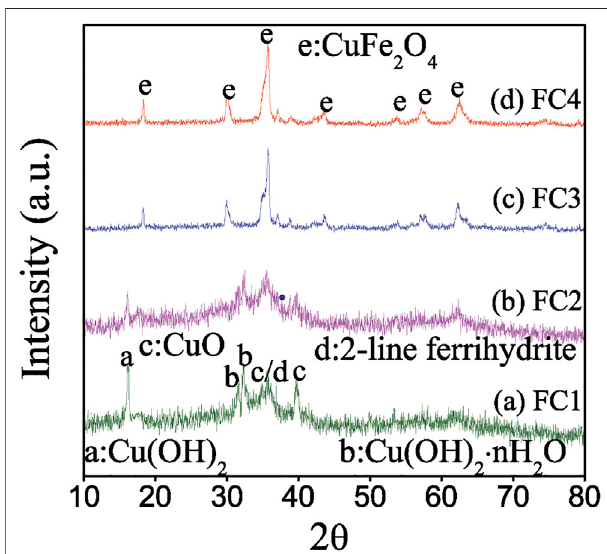
FIGURE1| X-raydiffractionpatternsoftheFe-Cubinaryoxides:(a)FC1, (b) FC2, (c) FC3 and (d) FC4. (a: Cu(OH) 2 , b: Cu(OH) 2 · nH 2 O, c: CuO, d: 2-line ferrihydrite and e: CuFe 2 O 4